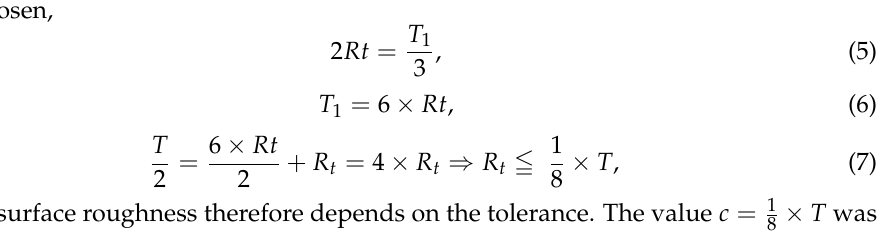
Figure 1. Surface roughness and dimensional tolerance.